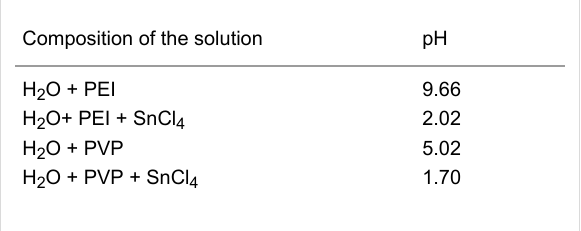
Composition of the solution